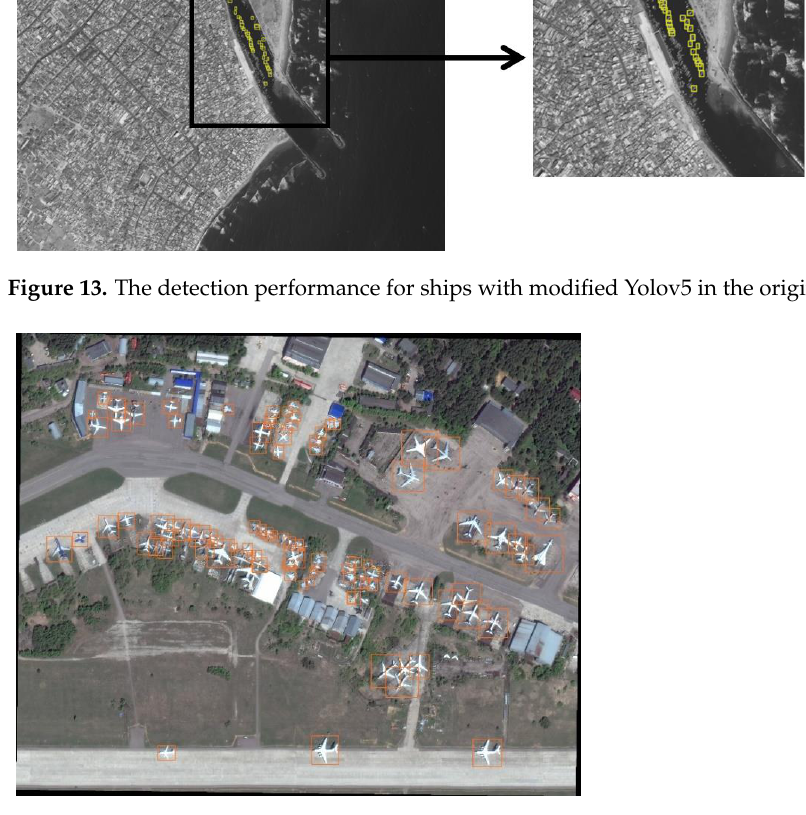
Figure 14. The detection performance for aircraft in the DOTA set.